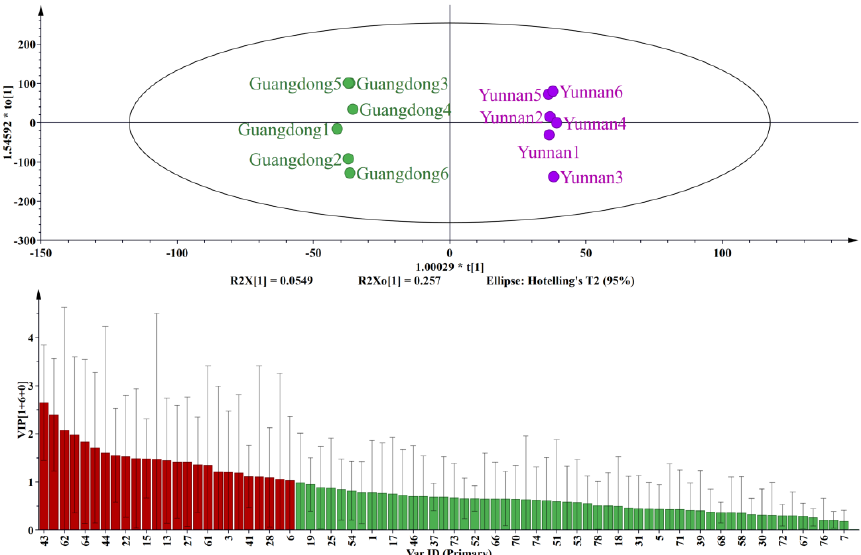
Figure 4. OPLS-DA analysis and VIP diagram of brown sugar in Guangdong and Yunnan.